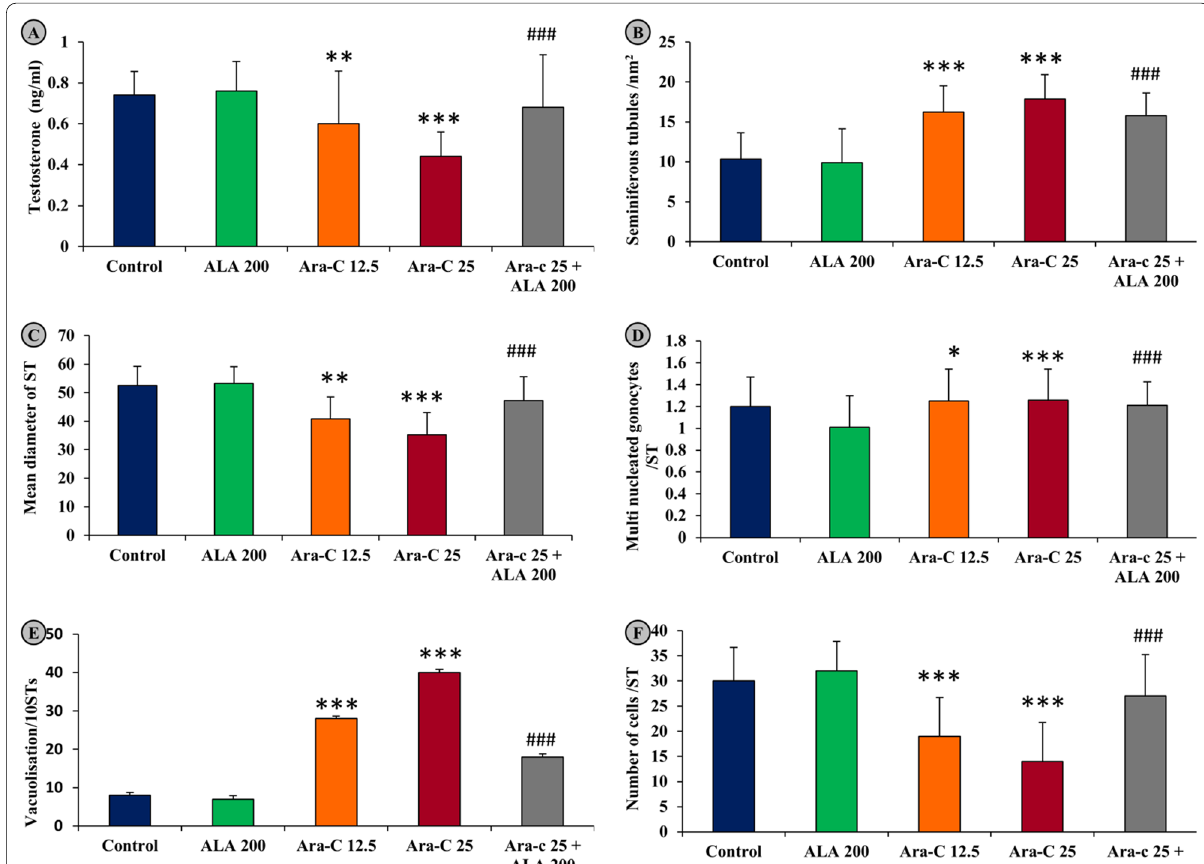
Fig. 5 Effect of Ara-C and ALA on A testosterone level, B density, C diameter, D multinucleated gonocytes, E vacuolization, and F number of cells of STs. All the values are expressed as mean SEM ( n 10). *** P < 0.001 versus control, ** P < 0.01 versus control, * P < 0.05 versus control; ### P < 0.001 ± = versus Ara-C 25 mg/kg. ALA alpha-lipoic acid 200 mg/kg, Ara-C cytarabine, ST seminiferous